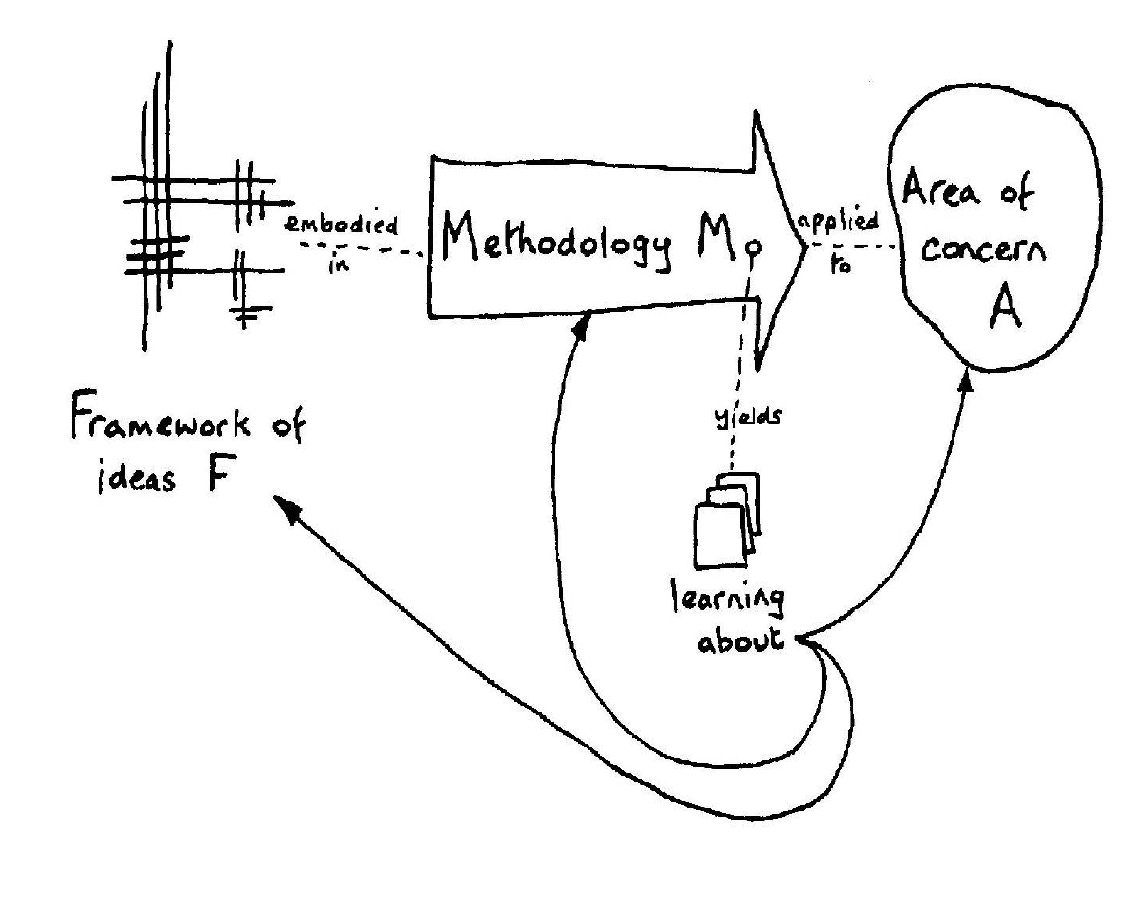
Figure 1 Elements relevant to any piece of research (Checkland and Holwell,